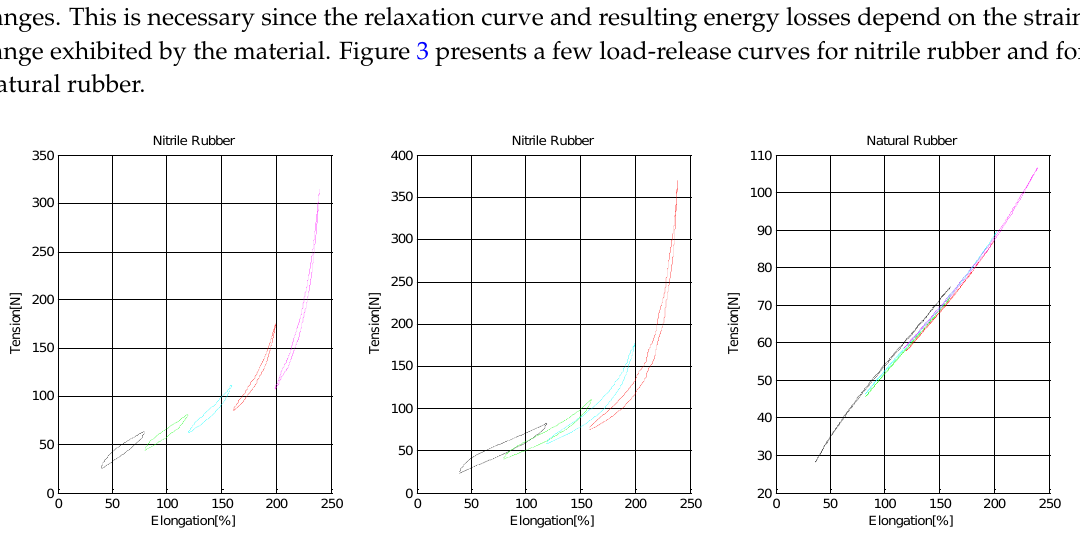
Figure 3. Experimental load cycle curves for natural rubber (right) and nitrile rubber. Leftmost is a 40% elongation range and center is for 80%.